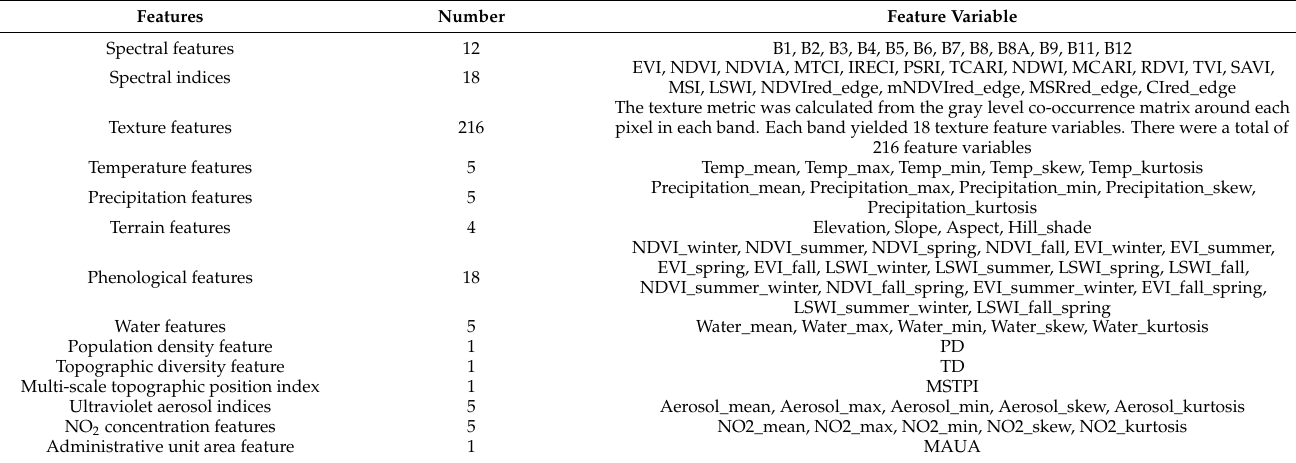
Table 3. Sixteen combination schemes of different features. Table 4. Specific feature variables of different